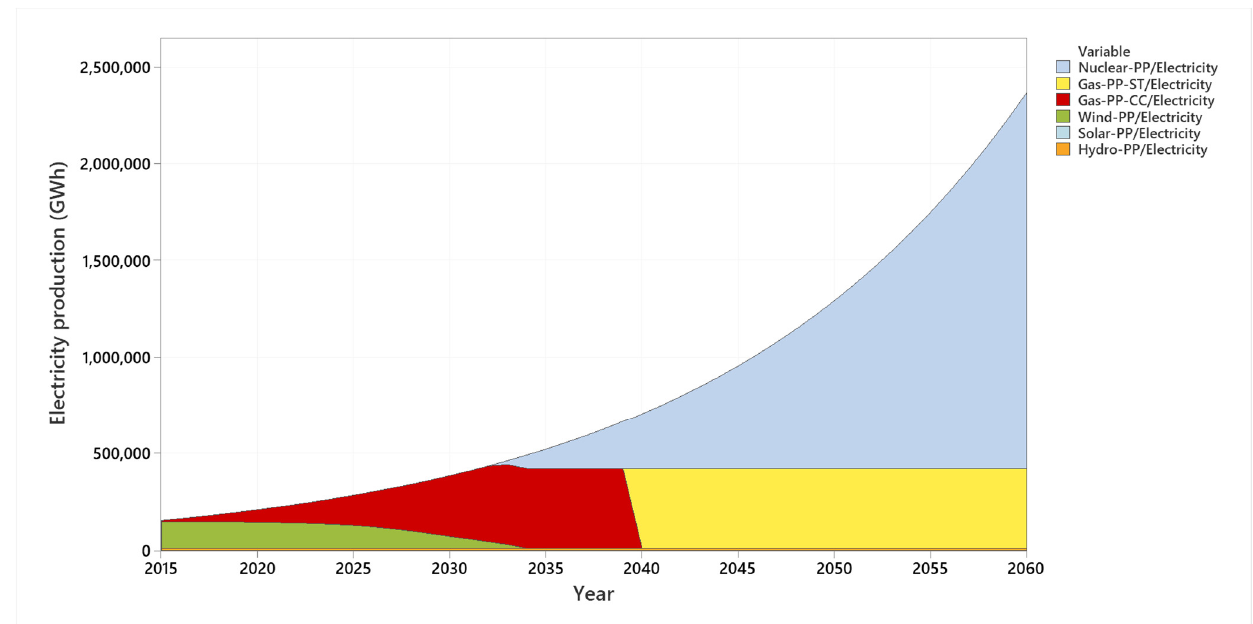
Figure 8. Balance of electricity production of all power plants for Third scenario.